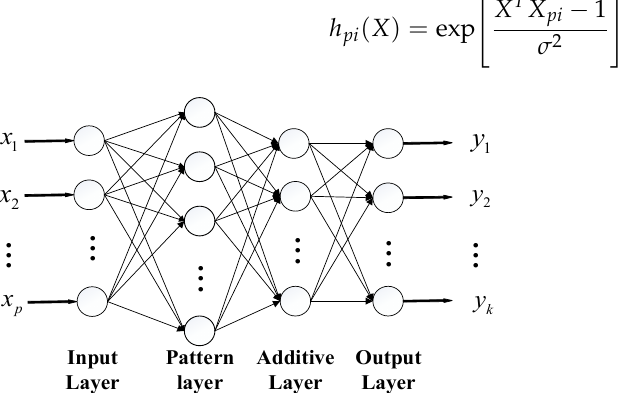
Figure 3. PNN model structure.